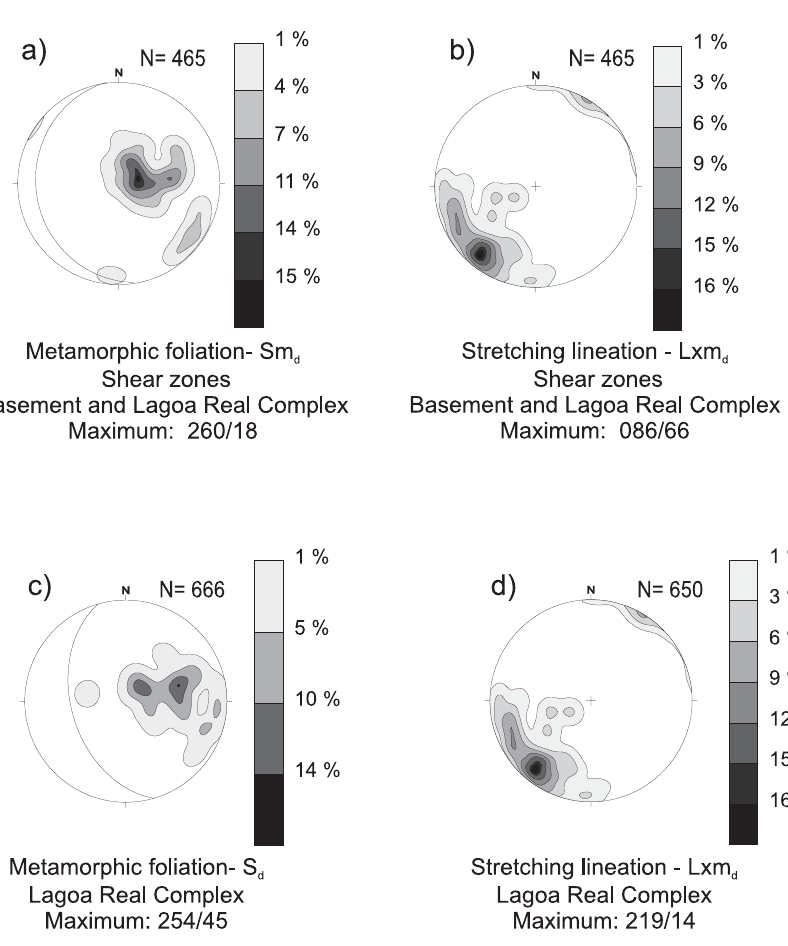
Fig. 10 – Equal-area, lower hemisphere stereonet plots of poles to foliations and lineations for the shear zones affecting the basement and Lagoa Real Complex in structural domain